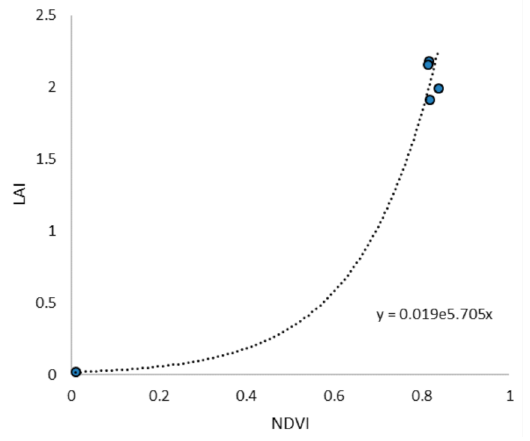
Figure 6. Exponential relationship between PAR-based LAI and